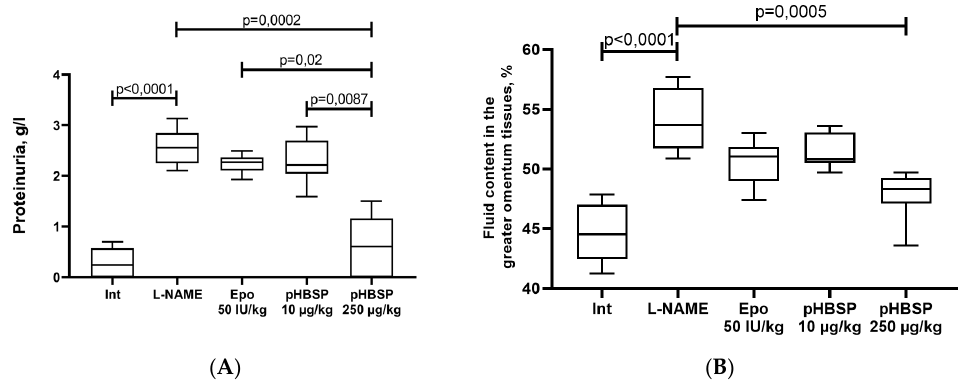
Figure 3. The effect of pHBSP on the proteinuria ( A ) and the fluid content in the greater omentum tissues ( B ) in animals with ADMA-like preeclampsia ( n = 10 animals in each group).